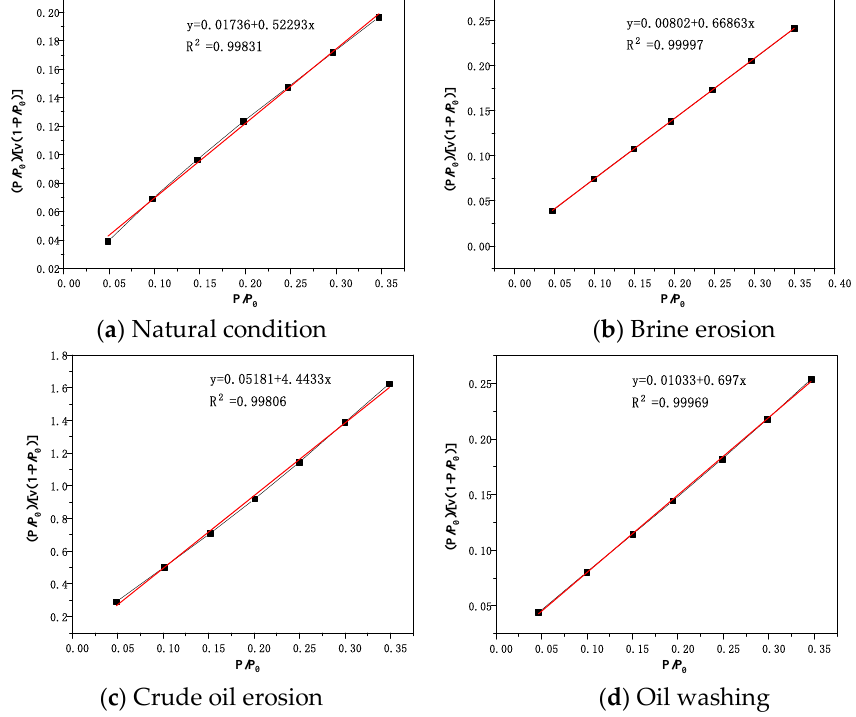
Figure 11. The BET diagrams of cap rock samples after di ff erent sample treatment